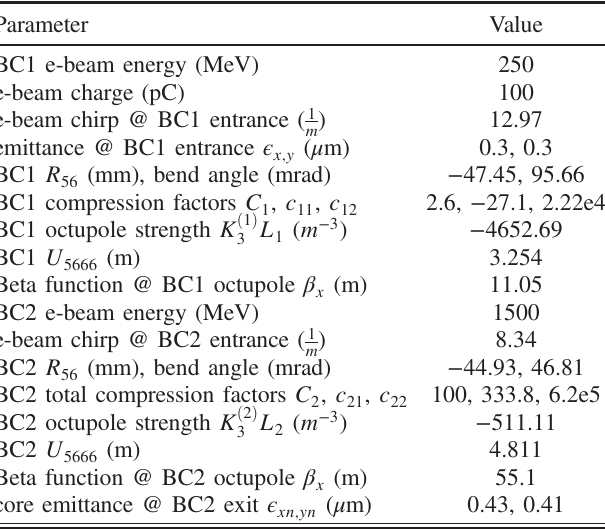
TABLE I. Parameters for LCLS-II double octupole scheme.